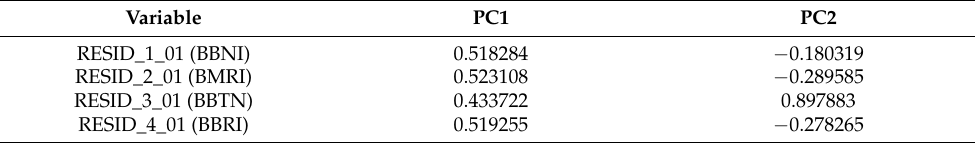
Table 4. PCA analysis for individual